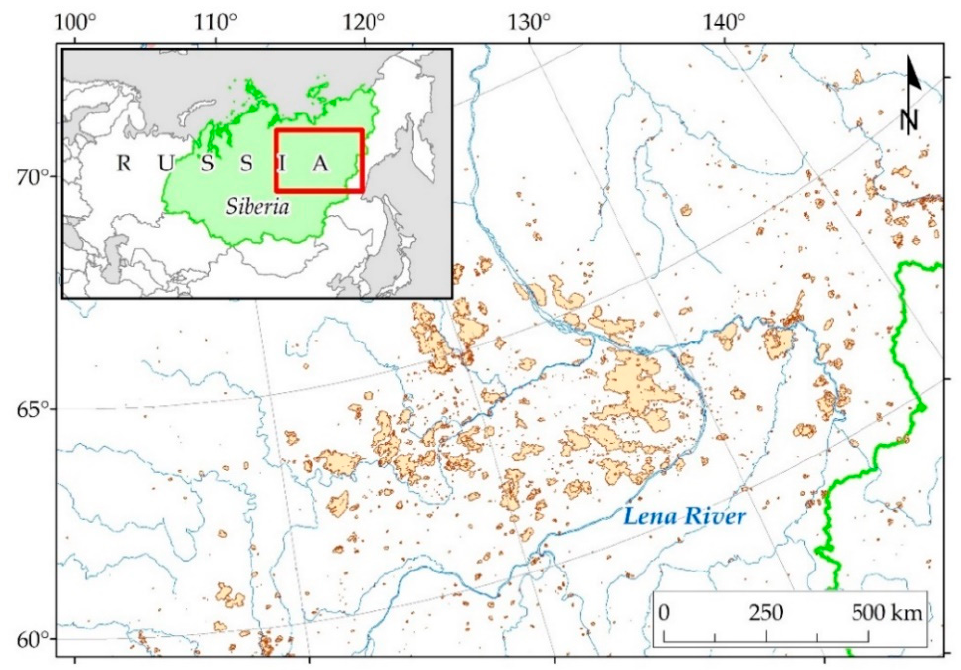
Figure 1. Fire polygons (light brown) in the Lena River Basin study area (eastern Siberia), derived from MODIS data (Terra and Aqua satellites) captured in 2021.